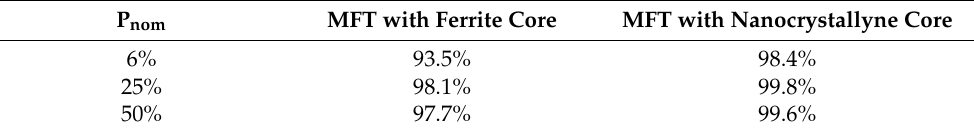
P nom MFT with Ferrite Core MFT with Nanocrystallyne